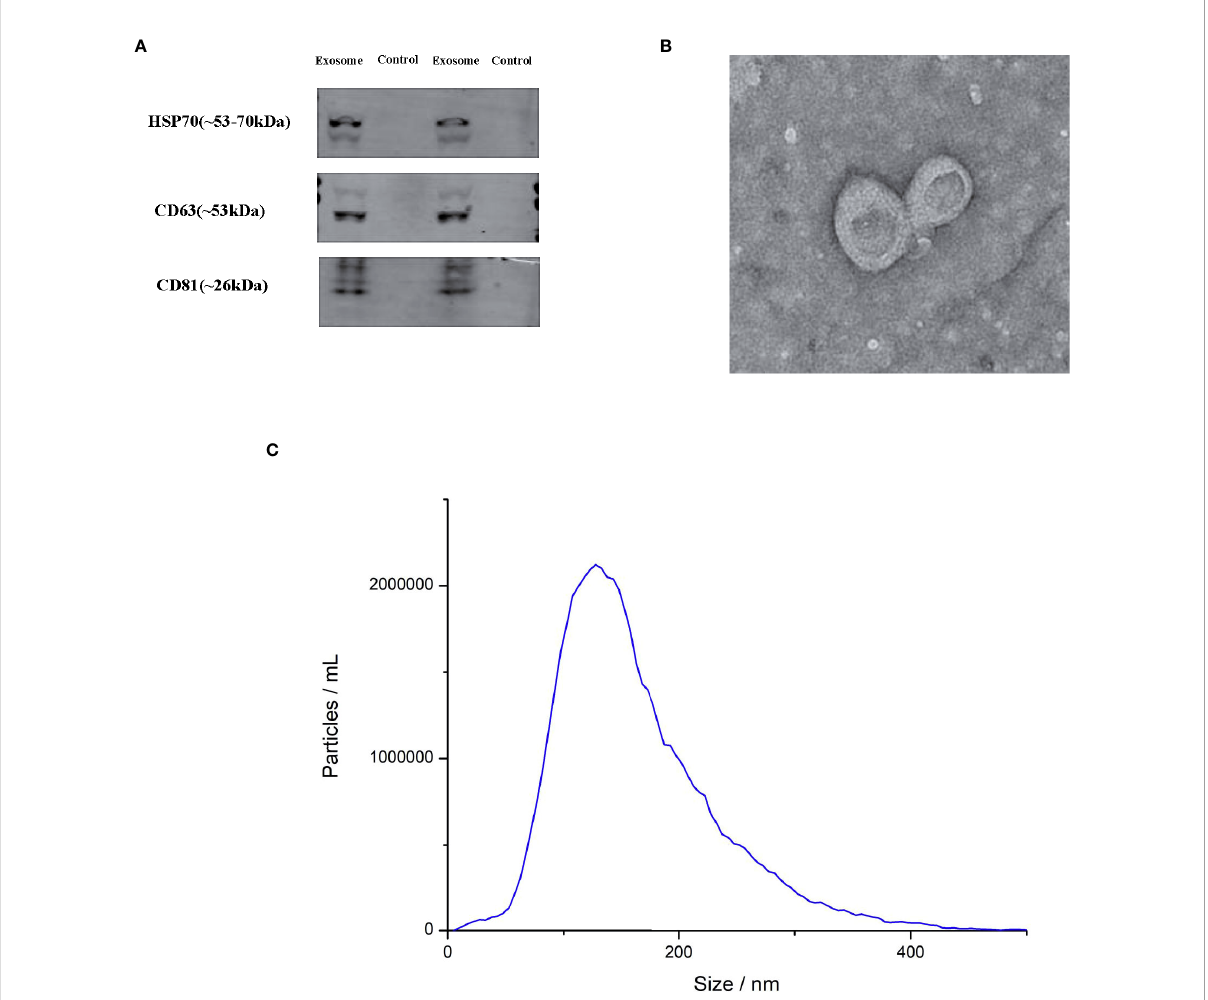
FIGURE 1 Characterization of exosomes. (A) Transmission electron microscopy (TEM) of exosomes (B) Western blot for HSP70, CD63 and CD81 in two exosomes and two negative controls (C) the exosome particle size and concentration measured by nanoparticle tracking analysis